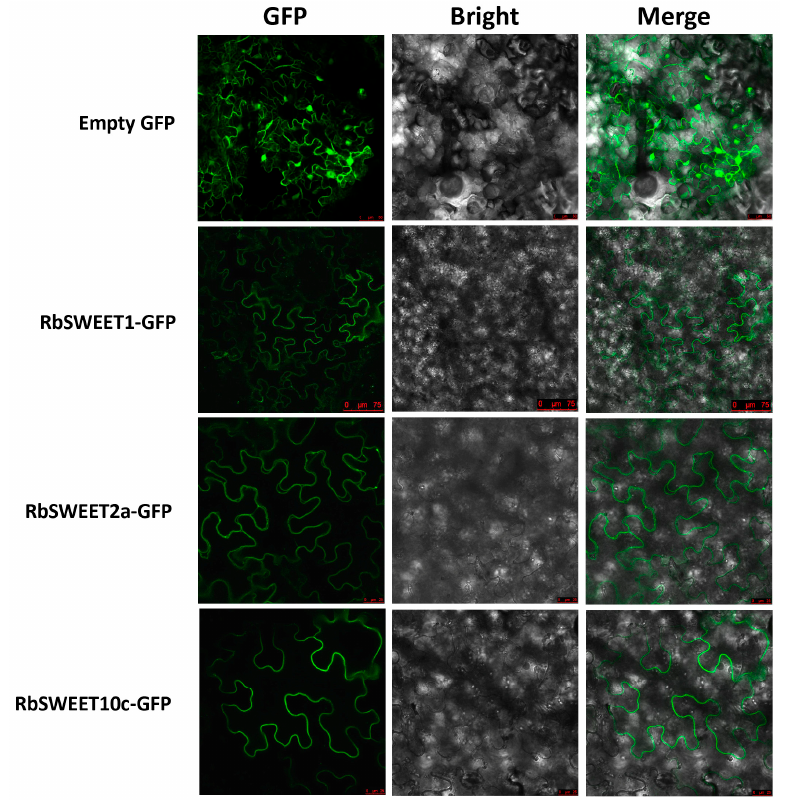
Figure 8. Subcellular localization of RbSWEET-GFP fusion proteins in tobacco leaves.